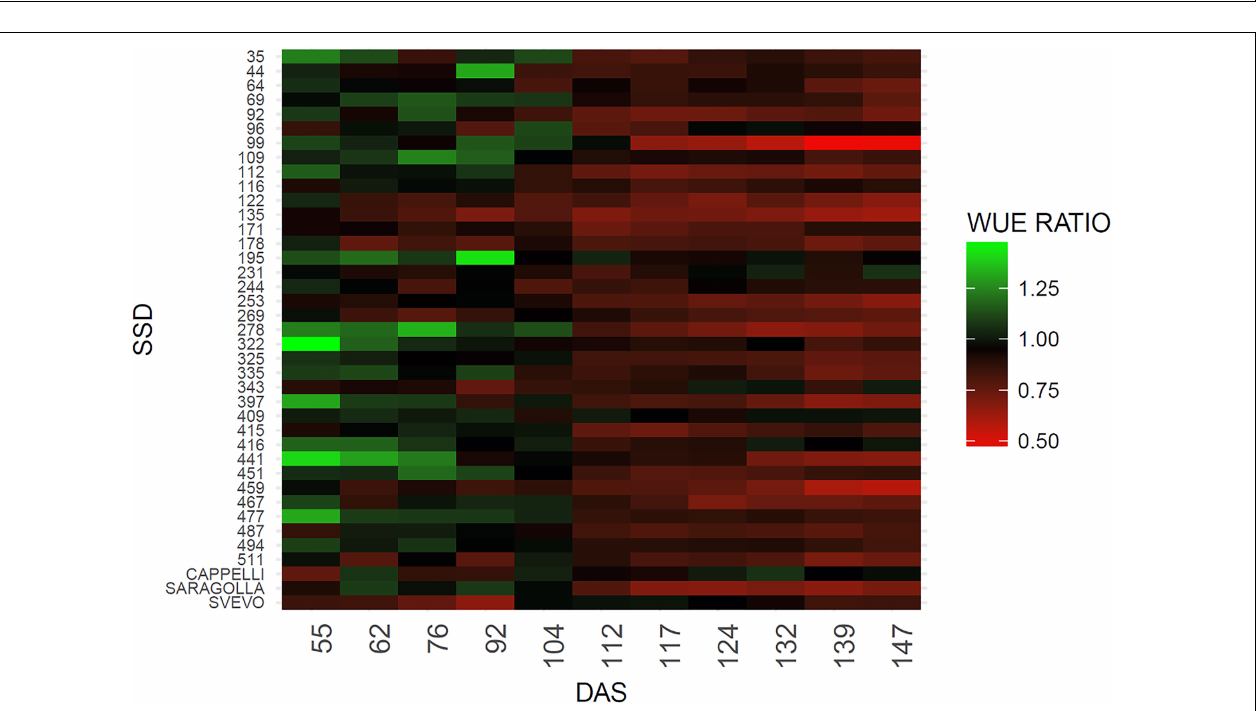
FIGURE 3 | (A) Boxplots showing the distribution of WUE values during the experiment. Black boxes are control plants, red boxes the water stressed lot. Drought stress was imposed at 104 DAS; (B) Correlation plot between WUE index and digital biovolume acquired by Scanalyzer at 139 DAS.